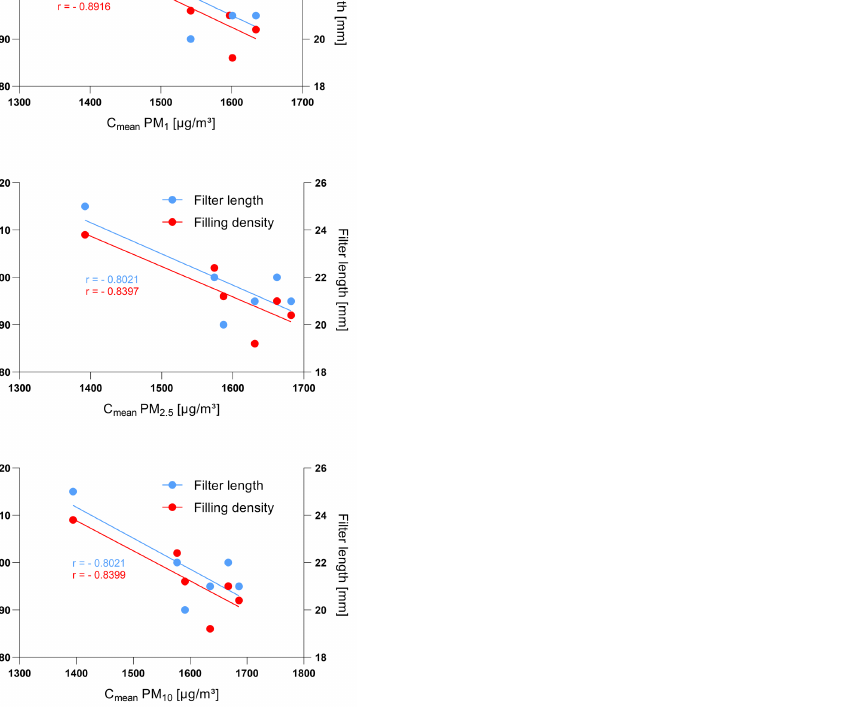
Figure 3. Correlations (Pearson) with linear regression lines of measured PM mean concentrations (C mean PM 1 , PM 2.5 , and PM 10 ) with ascertained filter lengths (blue, p (PM 1 ) = 0.044, p (PM 2.5 and PM 10 ) > 0.05)) and calculated filling densities (red, p (PM 1 ) = 0.017, p (PM 2.5 ) = 0.037, p (PM 10 ) = 0.036) of the private-label and brand-name cigarettes. r = Pearson’s correlation coefficient. p = Level of